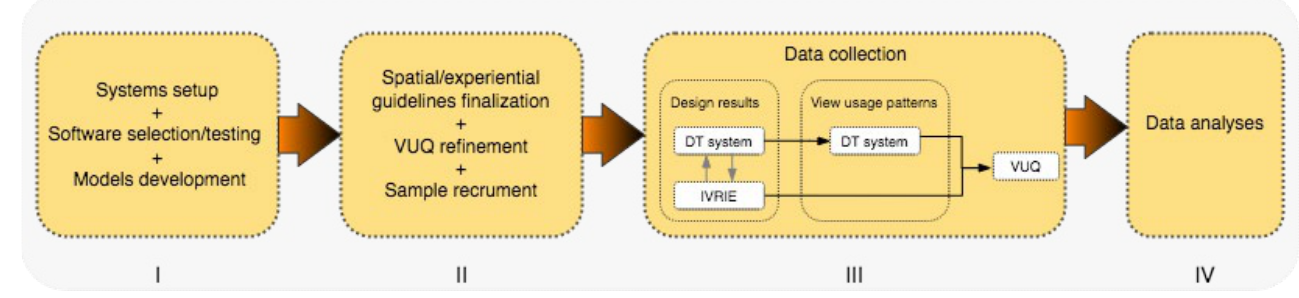
Figure 4. The phases of the